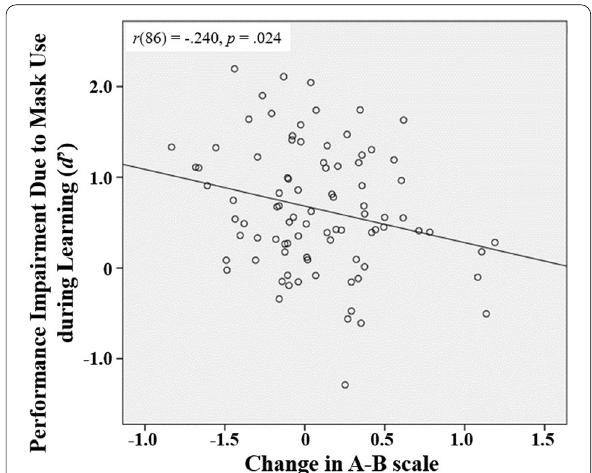
Fig. 4 Correlation between the change in A – B scale due to mask use during learning (unmasked–unmasked condition minus masked– unmasked condition; more positive change indicates larger change toward the more eyes‑focused Pattern B with mask use) and the corresponding performance impairment in d ′ : The more change toward the more eyes‑focused Pattern B , the less the performance impairment